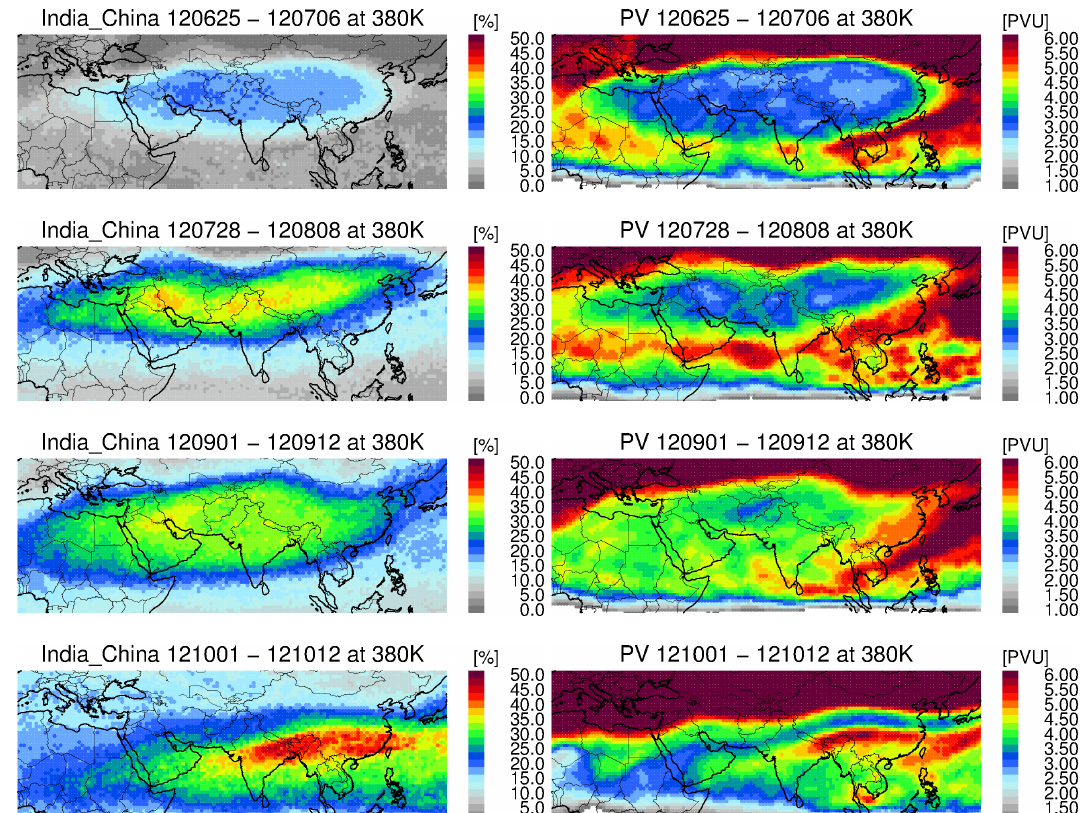
Figure 6. Twelve-day mean values of the contribution of the emission tracer for India/China (left) and PV (right) during four different phases of the Asian monsoon anticyclone: early phase (top), mid-phase (second row), end phase (third row) of the anticyclone, and after the breakup